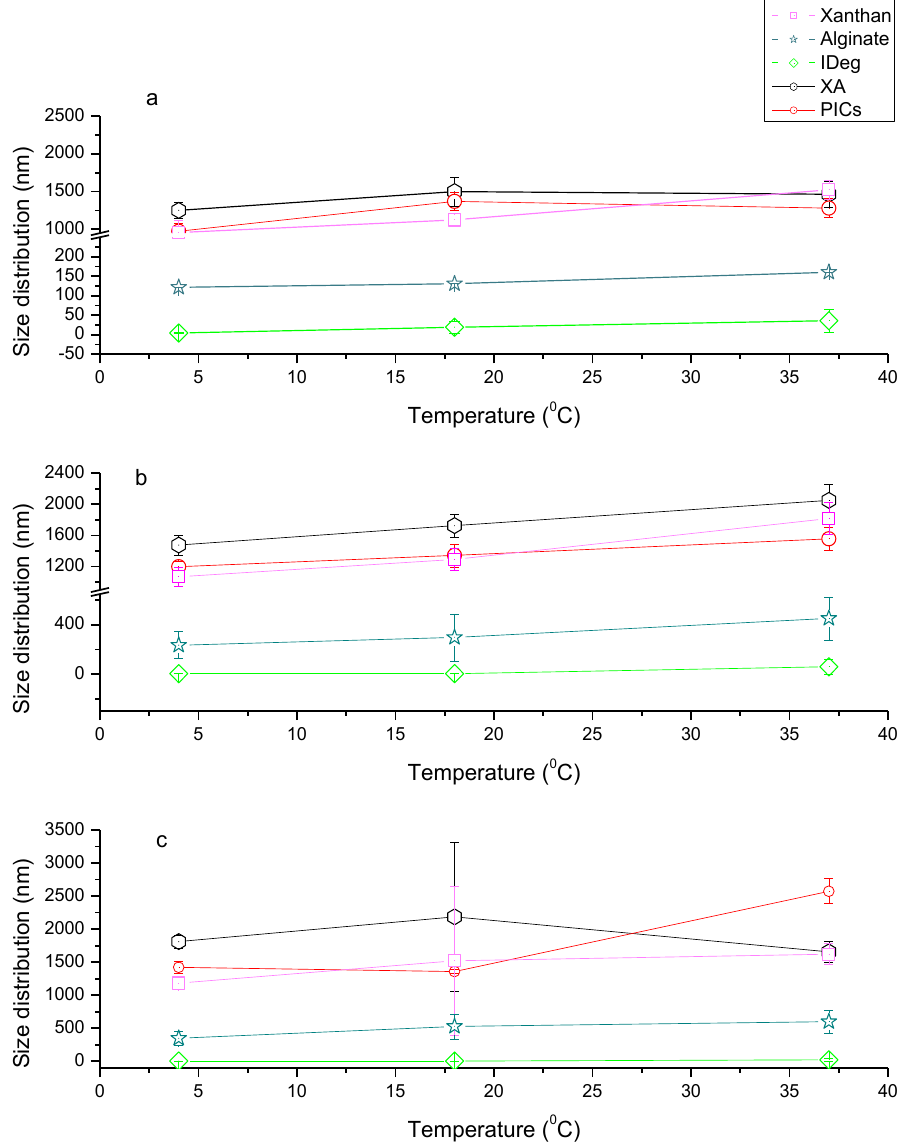
Figure 2. Particle size distribution of Xanthan (X), alginate (A), Insulin degludec (IDeg), XA, and PIC at a range of temperatures (4, 18 and 37 °C) on ( a ) Day 1, ( b ) Day 7 and ( c ) Day 14. The PSD for binary system (XA) at 40C on Day 1, was found to be ~1251nm. This was higher than both polysaccharides on their own, which reflects conformational changes in the structure of the macromolecules. Increase in temperature on Day 1 had an insignificant impact on PSD of XA (F 1,2 = 2.44, P = 0.36). However, when incubation time was increased, significant increase in size was observed with an increase in temperature, Day 7 (F 1,2 = 4382.43, P = 0.01). These changes in PSD were stable as no significant increase in PSD was observed from day 7 to 14 (F 1,2 = 4.52, P = 0.28). PSD of the PIC were also found to be almost an average of PSD of single components. PIC had a gradual increase in PSD with an increase in temperature and incubation time. Significant changes were observed on day 7 with an increase in temperature (F 1,2 = 3395.92, P = 0.01), respectively.